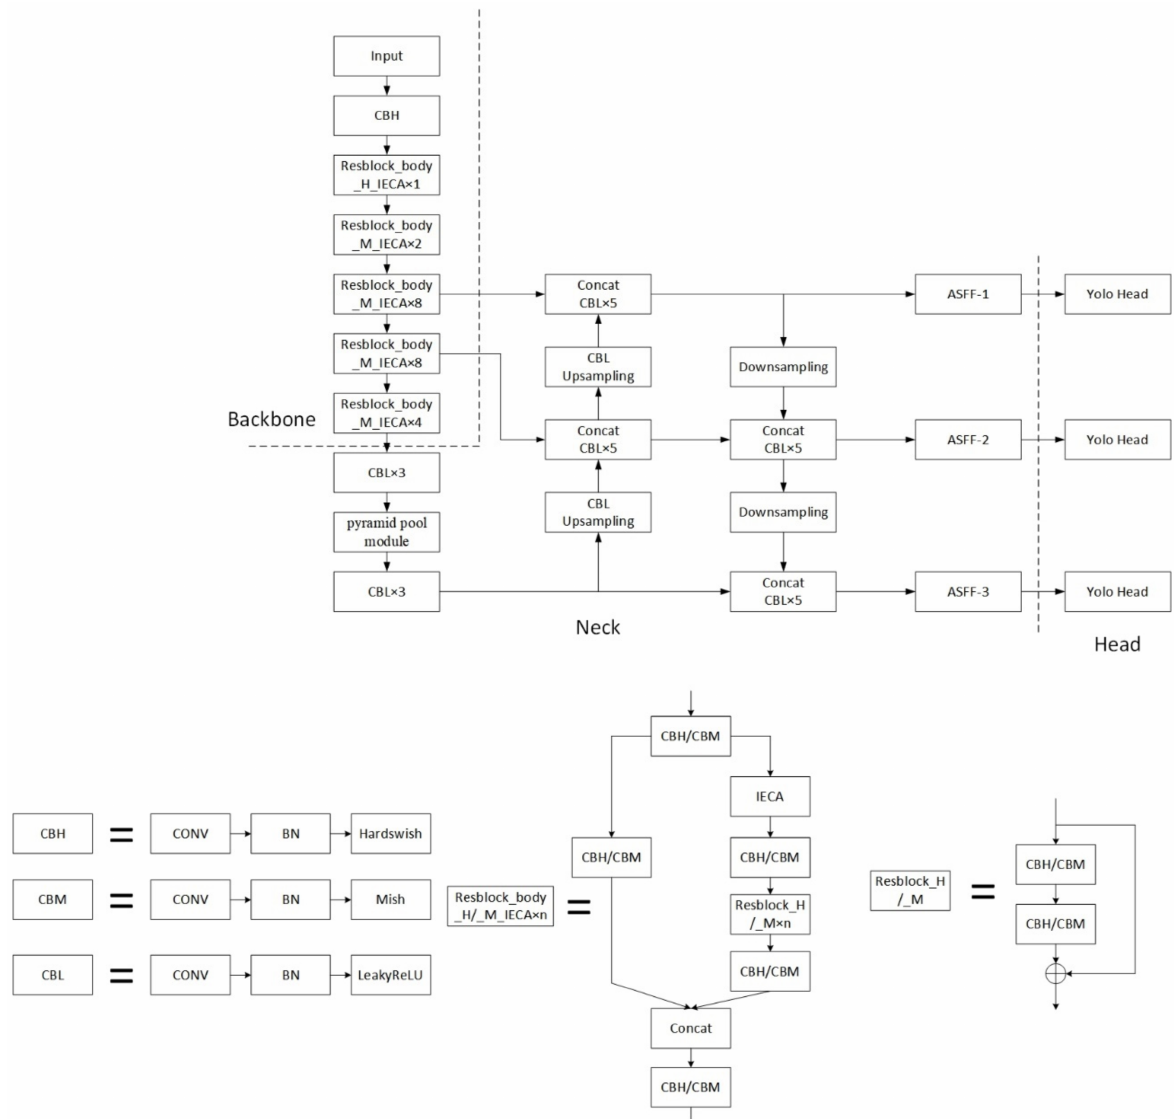
Figure 6. The YOLOD’s